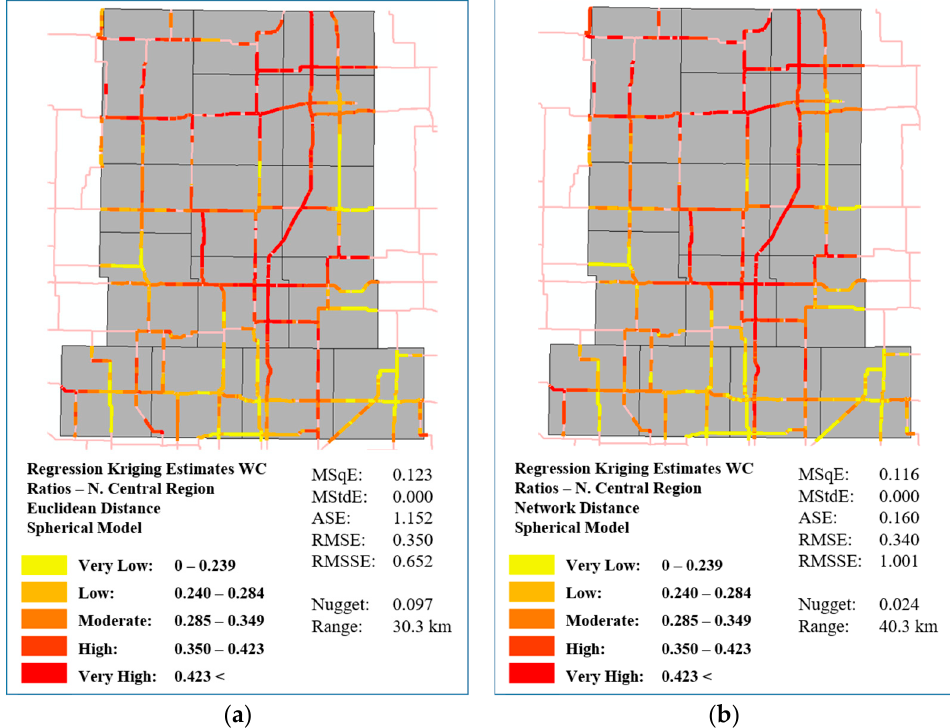
Figure 13. Regression Kriging using ( a ) Euclidean Distances and ( b ) Network Distances.